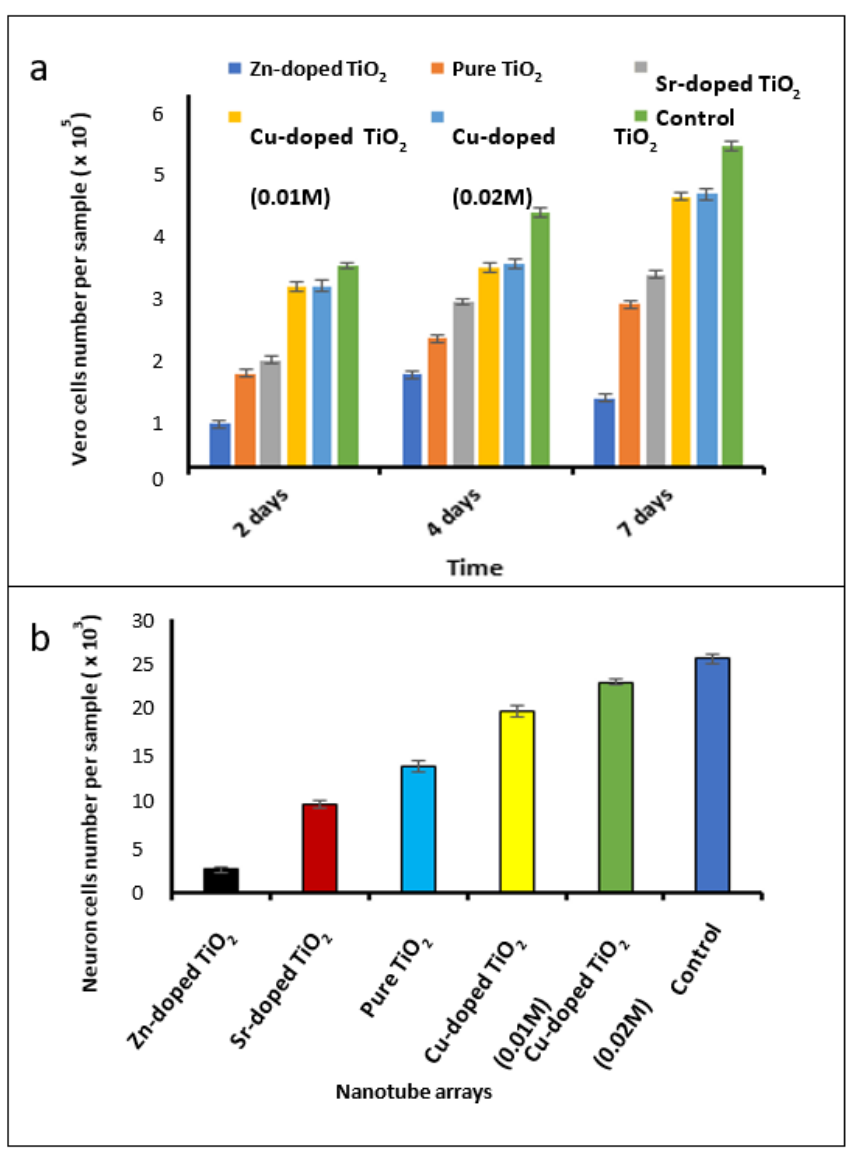
Figure 6. ( a ) Vero cell proliferation results after 2, 4, and 7 days and ( b ) neuron cell numbers on the fabricated nanotube arrays after 3 days (error bars show standard deviation for n = 3